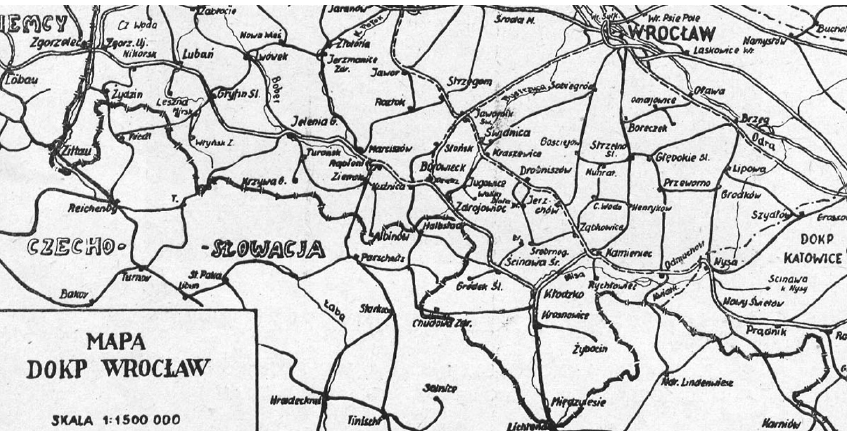
Fig. 3. Part of Mapa DOKP Wrocław , 1:1,500,000,